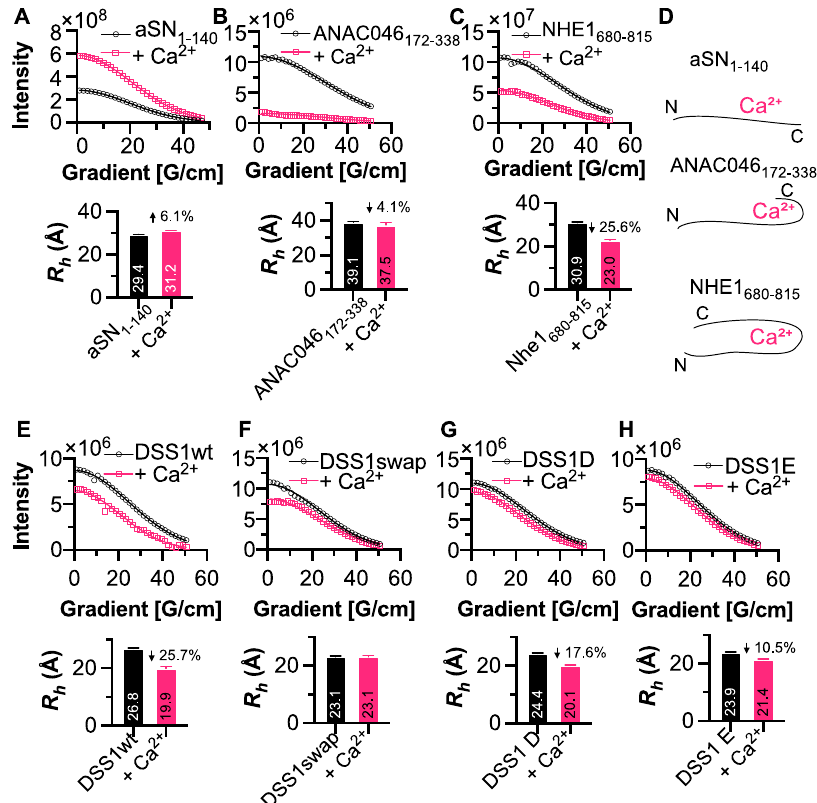
Figure 4. Calcium-induced conformational changes in IDPs . DOSY NMR data measuring the decay of the intensities of the methyl regions (centered within 0.85–0.9 ppm) as a function of increasing gradient strength. ( A ) DOSY NMR data demonstrating that CaCl 2 causes an elongation of aSN 1-140 . ( B ) DOSY NMR data for ANAC046 172-338 in the presence and absence of CaCl 2 . ANAC046 172-338 R h was reduced by ~1.5 Å. ( C ) A conformational shift was observed in NHE1 680-815 , whereby the protein R h becomes ~8 Å smaller upon calcium binding. ( D ) Hypothetical conformational changes occurring upon CaCl 2 + interaction. DOSY NMR data of DSS1wt ( E ), DSS1swap ( F ), DSS1D ( G ), and DSS1E ( H ). Arrows indicate increase (up) or decrease (down) in R h . All proteins were measured at a ratio of 1:250 to CaCl 2